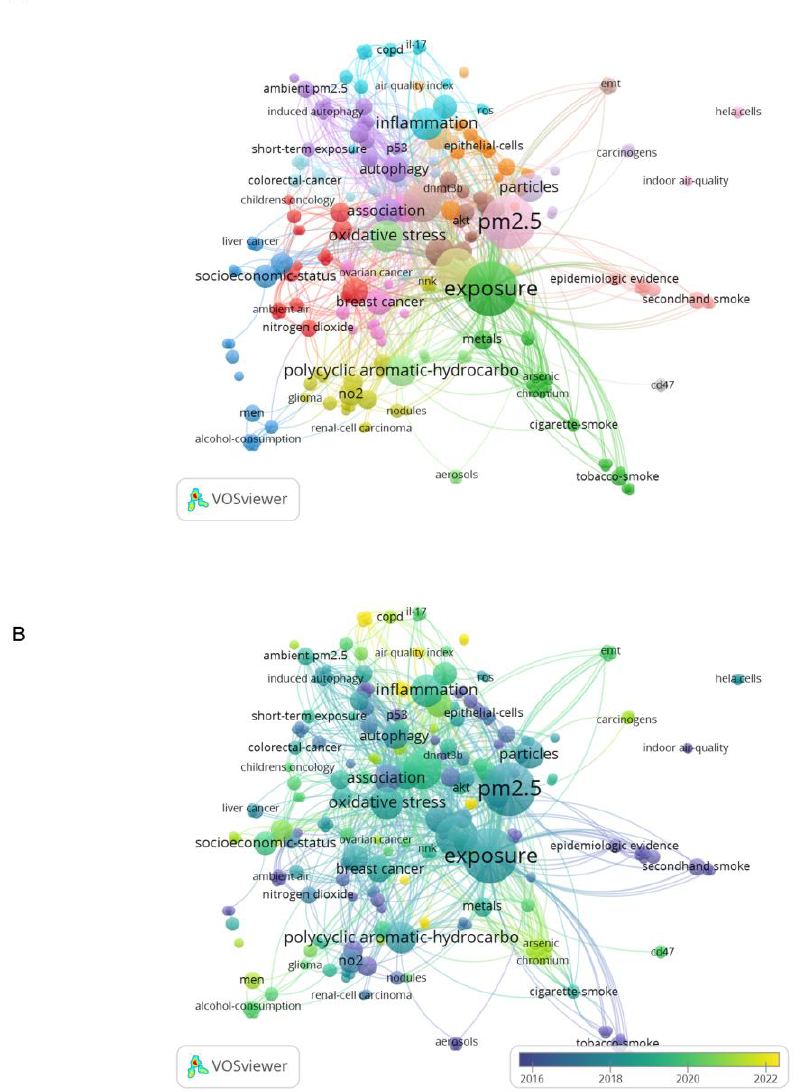
Figure 6. Co-occurrence analysis of keywords of fine-extracted 94 articles. ( A ) Network visualization of keywords of studies. ( B ) Distribution of keywords according to average publication year (blue: earlier, yellow: later).